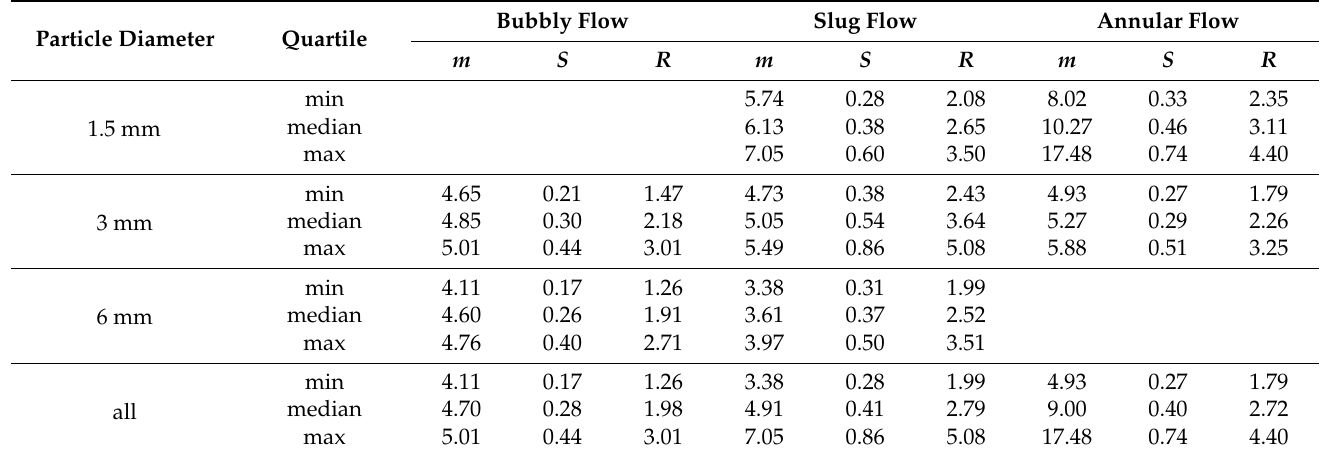
Table 2. Distribution of time domain parameters of flow